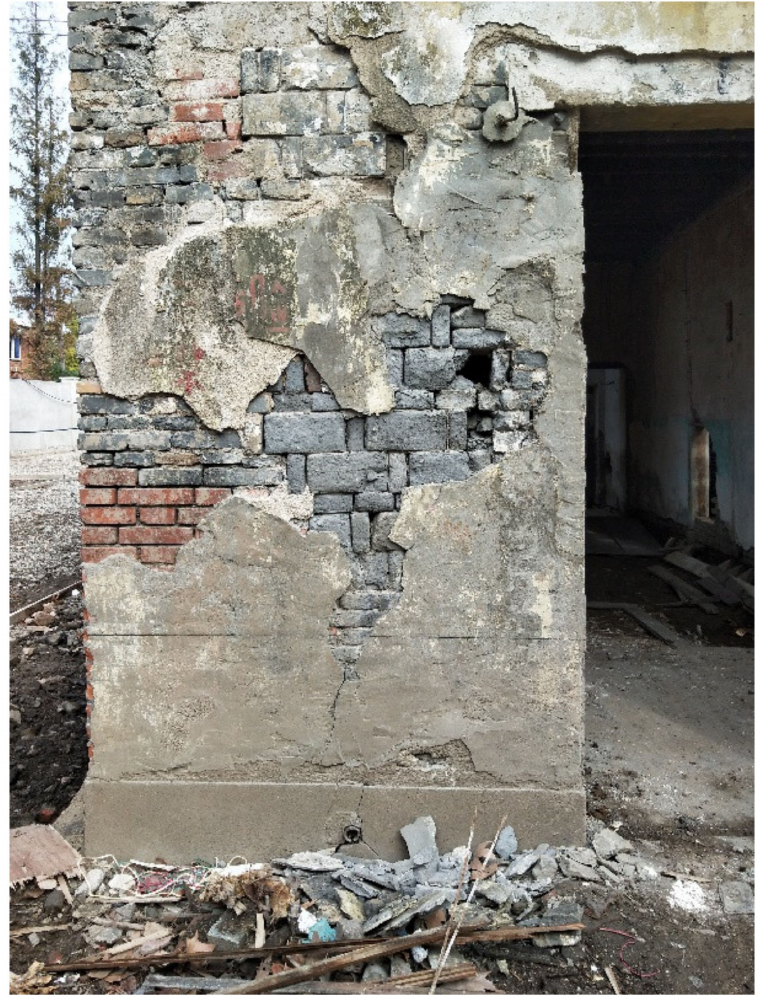
Figure 21. A wall made of different bricks of the “Tianbaoli”